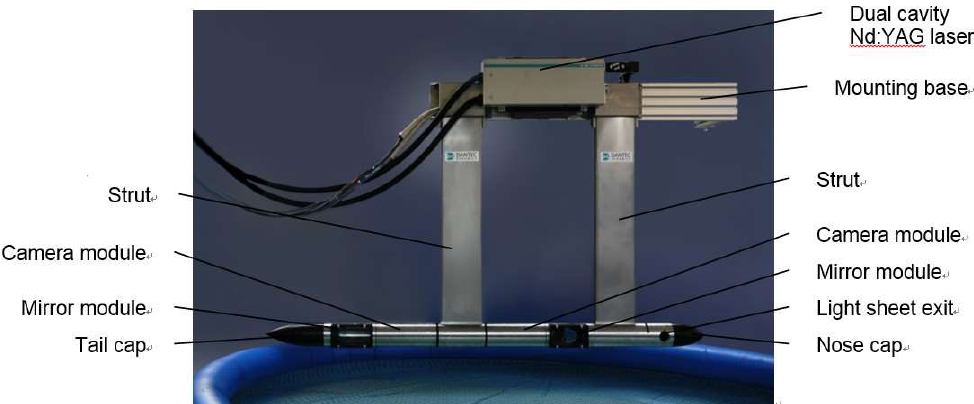
Figure 2. Stereoscopic towing tank particle image velocimetry (PIV) probe and laser.